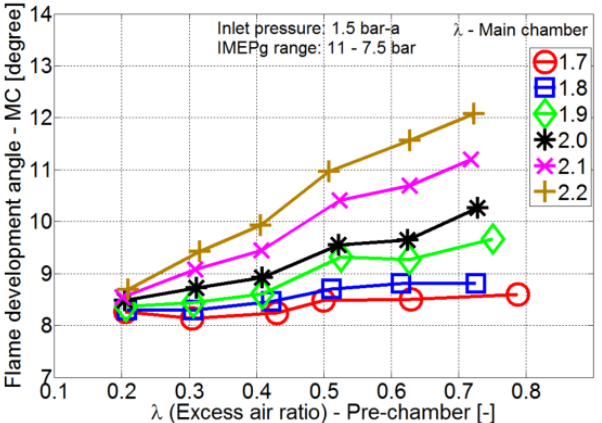
Figure 7. Main chamber flame development angle for different excess air ratios in the pre-chamber and main chamber [35].